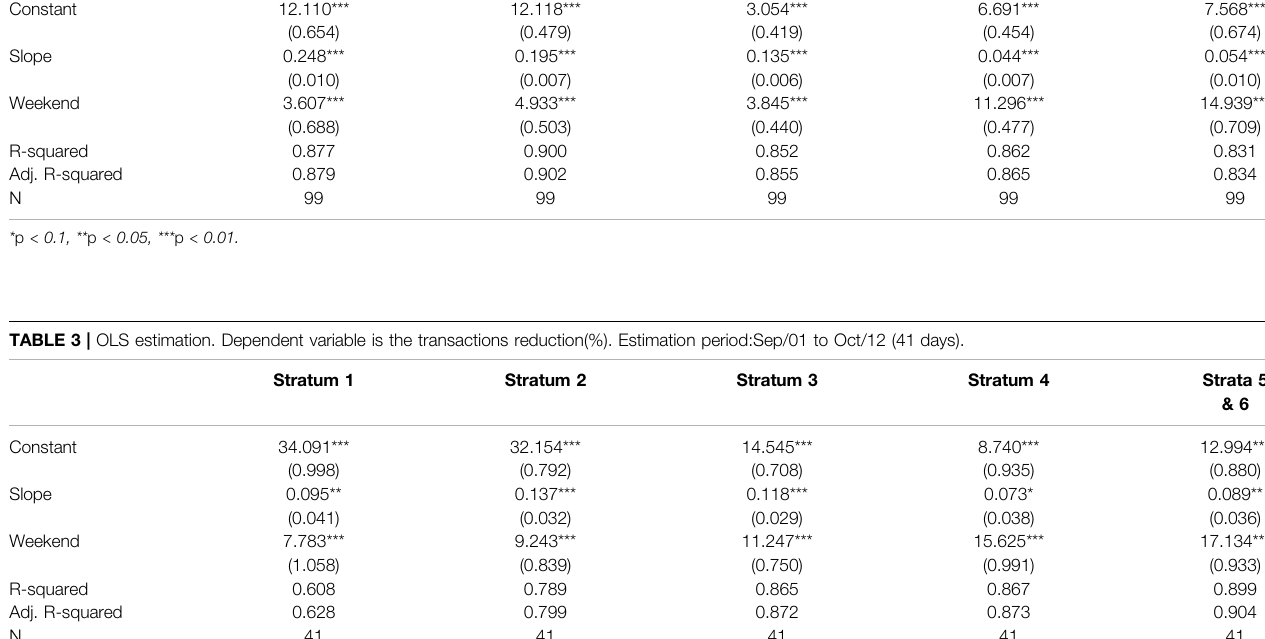
TABLE 2 | OLS estimation. Dependent variable is the transactions reduction (%). Estimation period: Mar/20 to Jul/13 (99 days). Stratum 1 Stratum 2 Stratum 3 Stratum 4 Strata 5 Constant